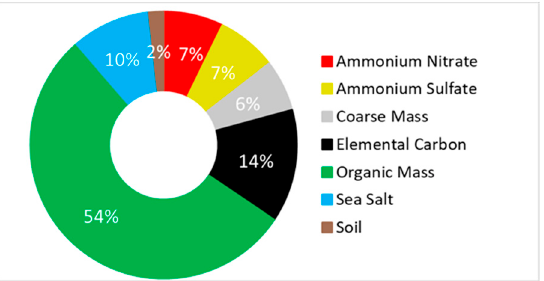
Figure 4. PM 2.5 contributions to reconstructed light extinction at the Bosque del Apache IMPROVE site (BOAP1) on 28 November 2018.